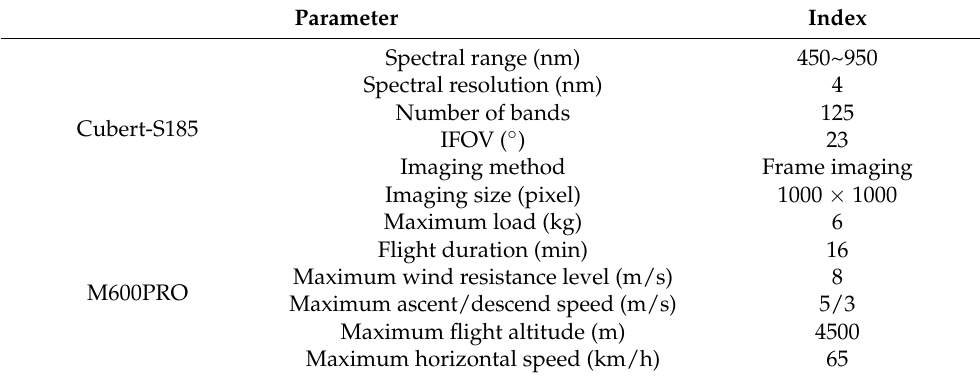
Table 1. Specifications of Cubert-S185 Hyperspectral Sensor and DJI-M600PRO UAV.